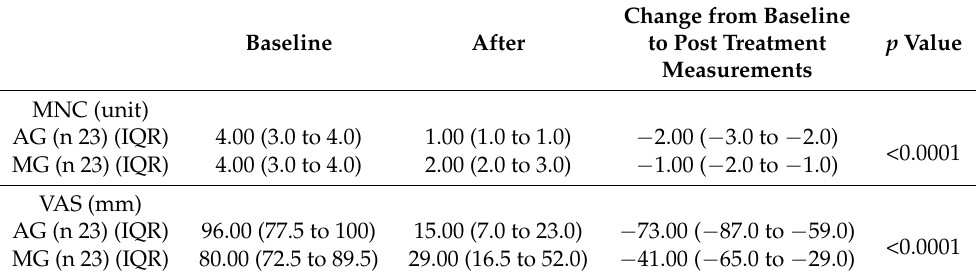
Table 3. Changes in the modified NIWA classification and visual analogue